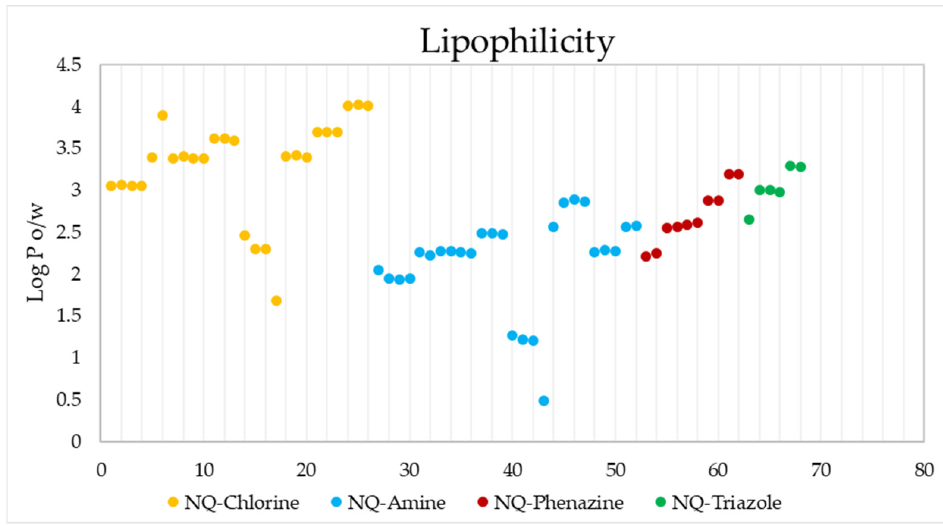
Figure 10. Lipophilicity values of the 68 naphthoquinone derivatives.